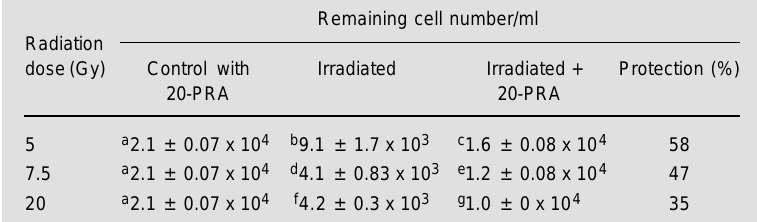
Table 1 - Effect of 1 nM 20-PRA as a radioprotective agent at various radiation